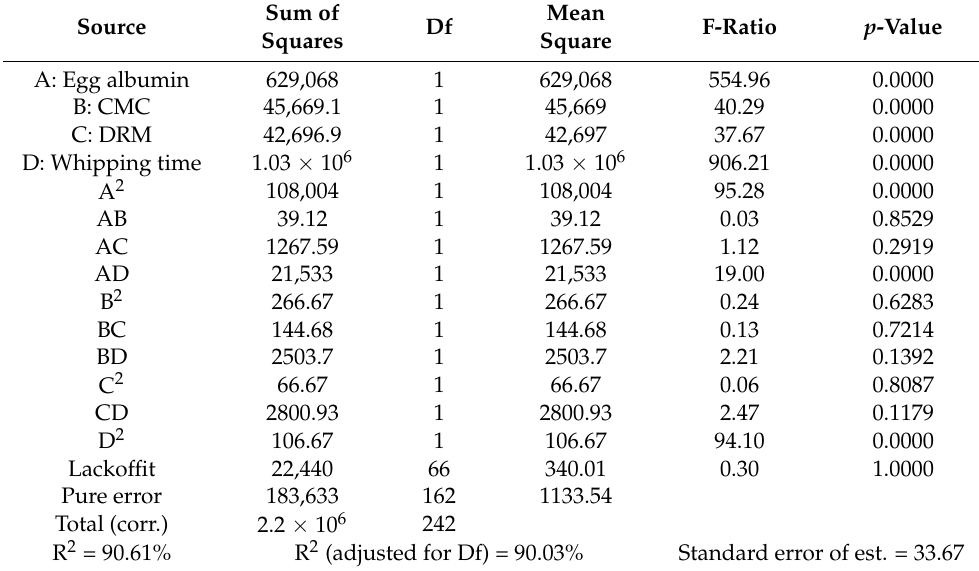
Table 2. Analysis of variance for foam